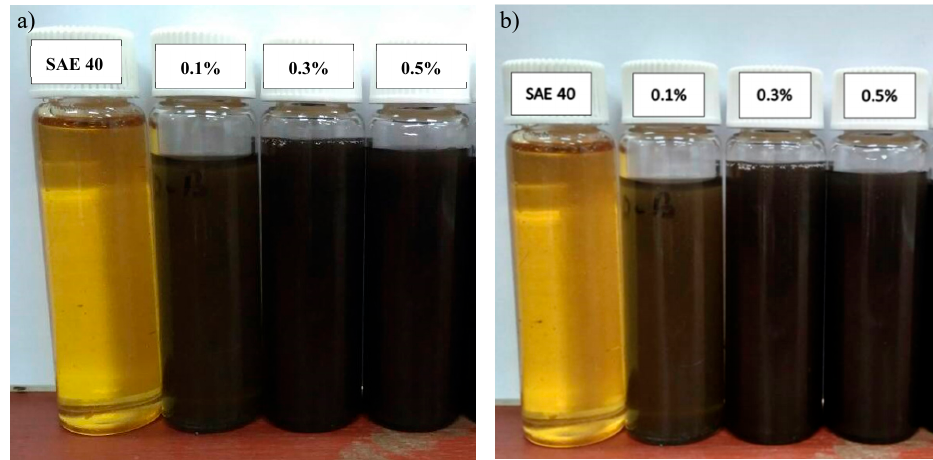
Figure 11. ( a ) Sedimentation at 0 week, ( b ) Sedimentation at 4 weeks.